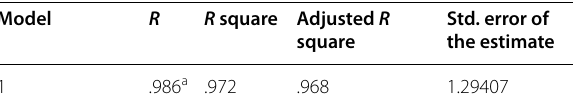
R .986 is the correlation between the observed and predicted value of the = decomposition